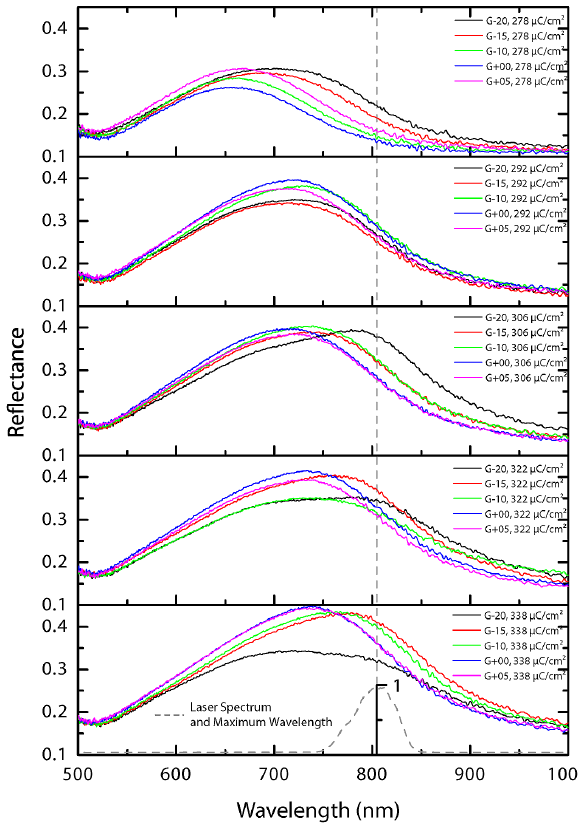
Figure 11: Spectral response of the batch of bow-tie arrays, ar- ranged by the processing parameters described above. The spec- tral response is classified by the reflected fraction of applied white light, normalised for the reflection from the pure substrate. Also shown is the normalised laser spectrum.